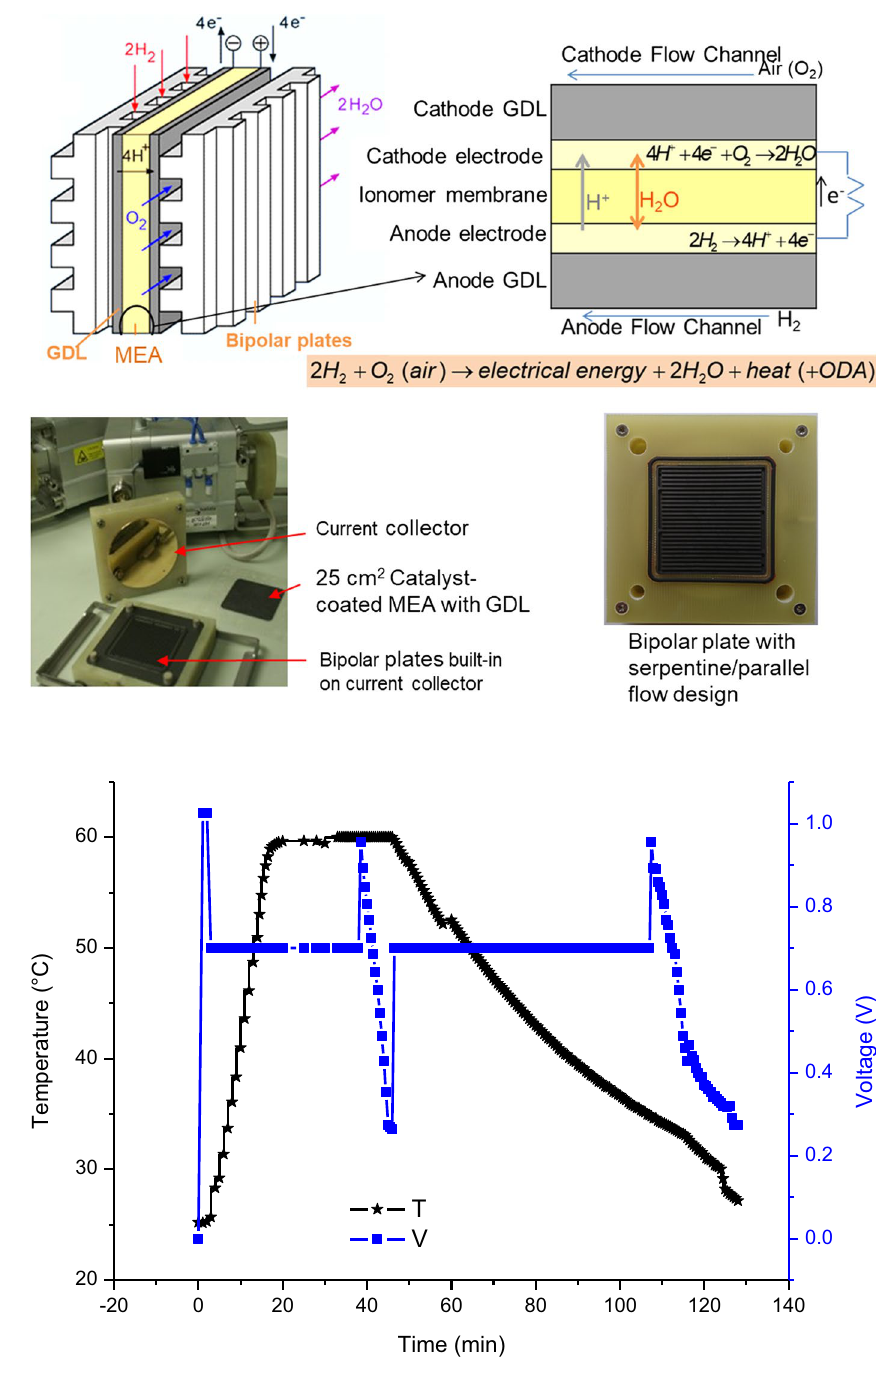
Fig. 2. The single cell was heated to 60 °C at 0.7 V, 100% RH and 1.8/2.5 anode/cathode stoichiometric ratio. When the fuel cell reached 60 °C and stabilized for 15 min, a polarization (IV) curve was taken and the cell was cooled to room temperature, followed by 5 min rest prior to restart. The cell was purged with nitrogen for only 5 min at the end of each cycle to minimize hydrogen/air interface